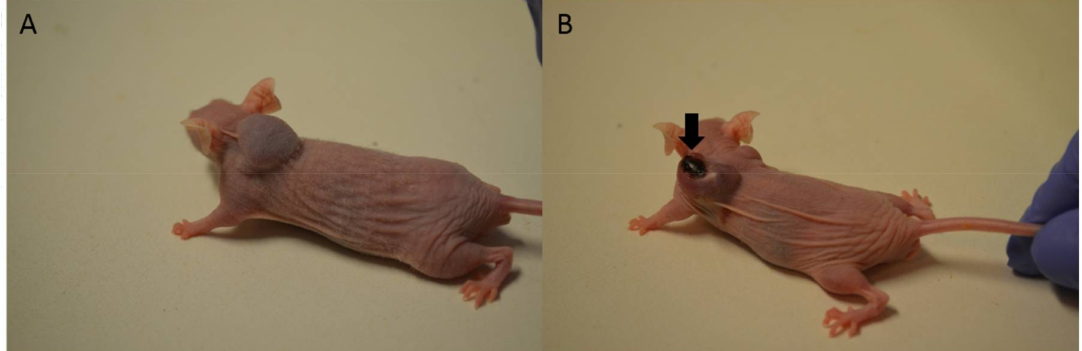
Figure 7. Macrophotographs of tumor growth on mice without ( A ) and with ( B ) visible skin necrosis in the place of intratumoral injections of Au-GSH-Dox ( A ) and Dox ( B ). Arrow indicates skin